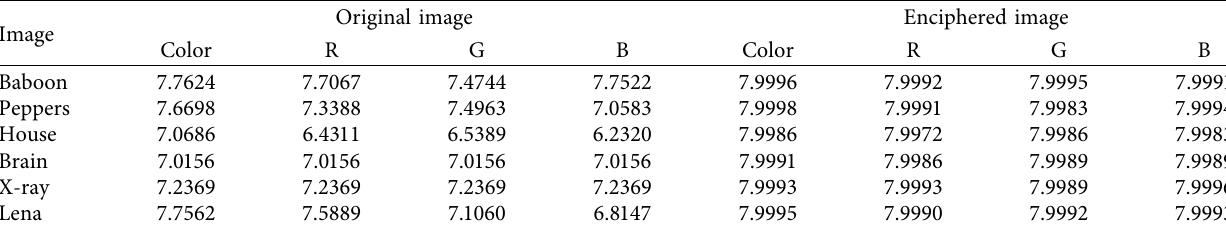
Table 1: Entropy measures for different images.